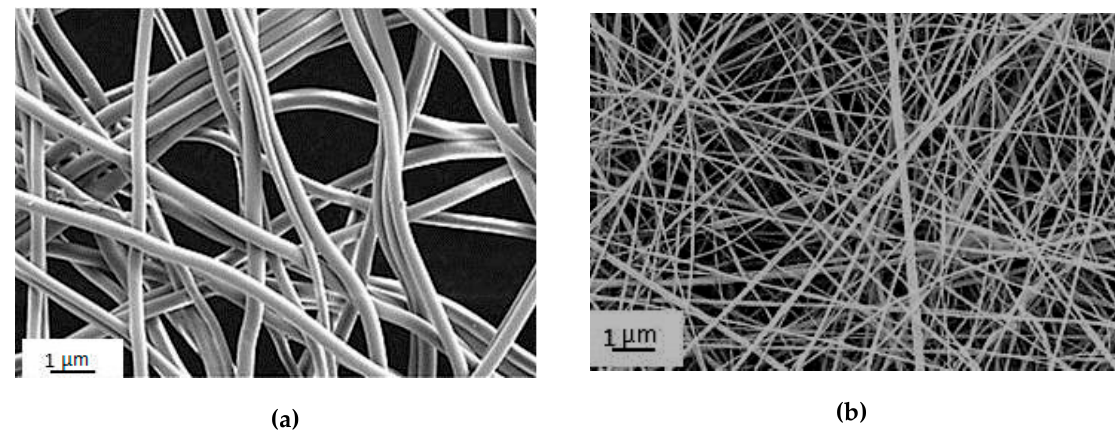
Figure 3. Microphotographs of CoPA fibers ( a ) and chitosan-based composite nanofibers containing chitin nanofibrils ( b ).